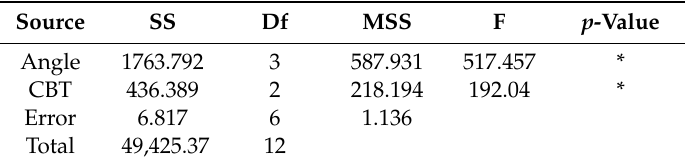
Table 1. ANOVA results of the pull-out force on bone’s